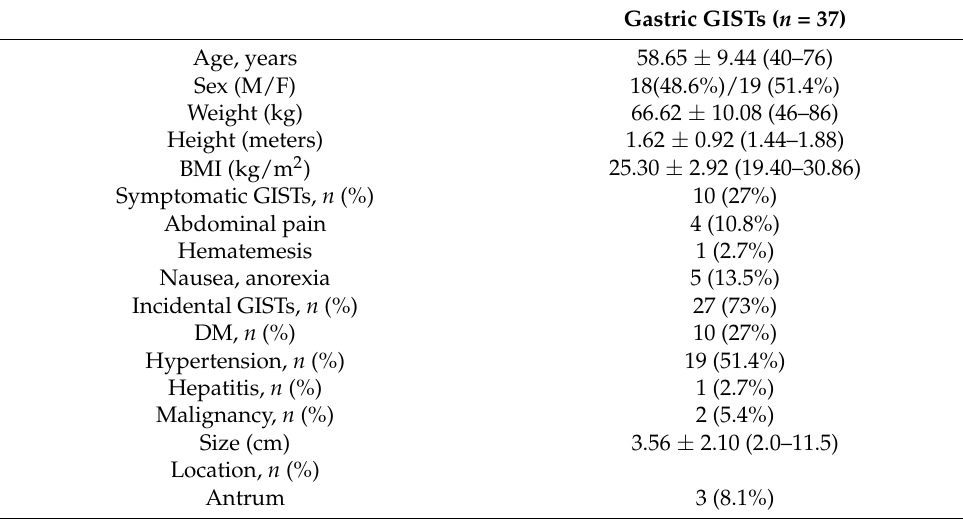
Table 2. Baseline characteristics of enrolled